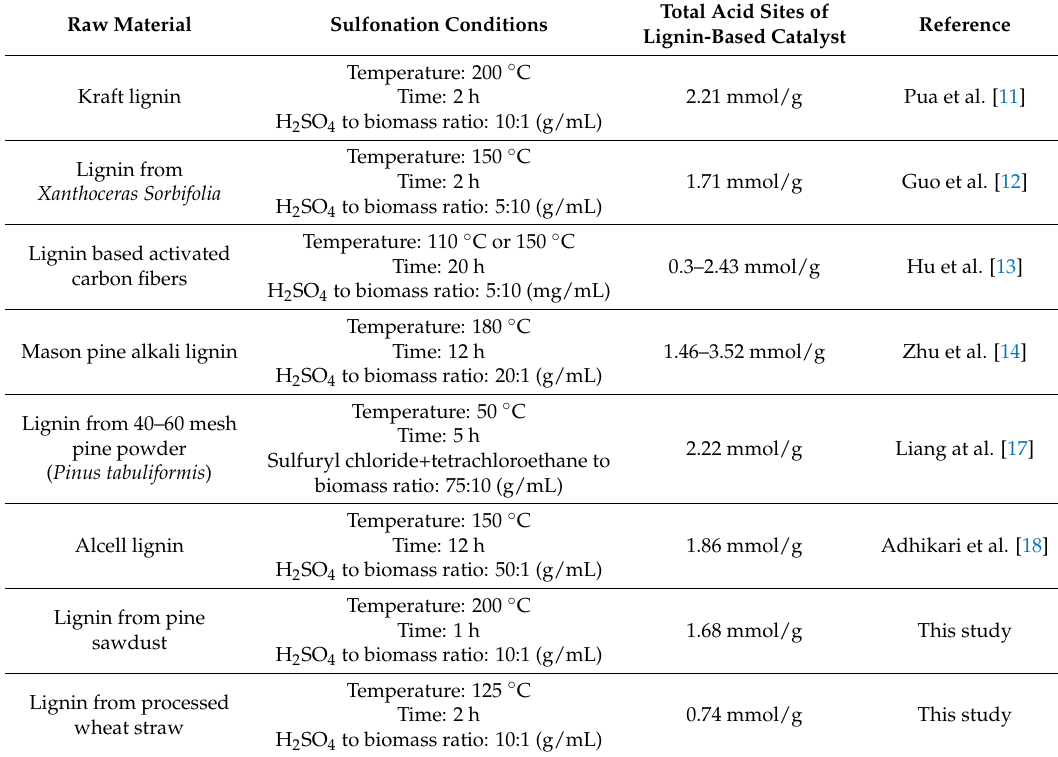
Total Acid Sites of Lignin-Based Catalyst